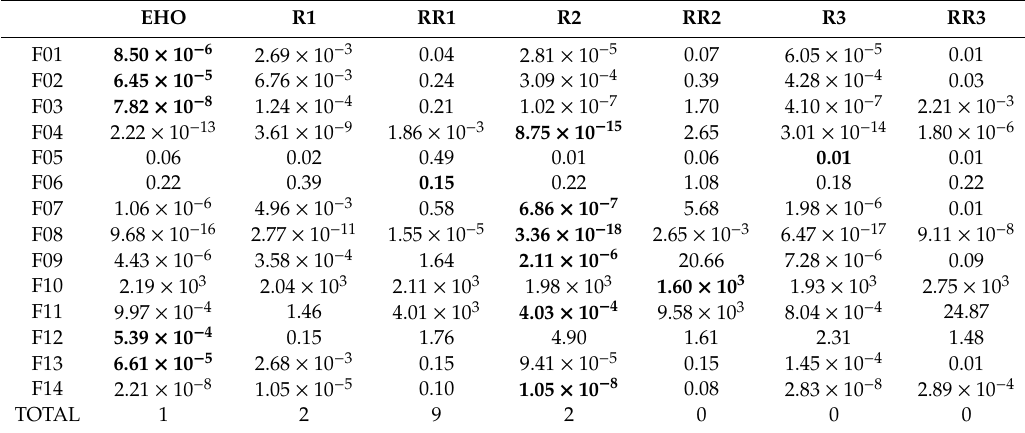
Table 14. Mean function values obtained by EHO and six improved methods on fourteen CEC 2017 constrained optimization functions with D = 50.